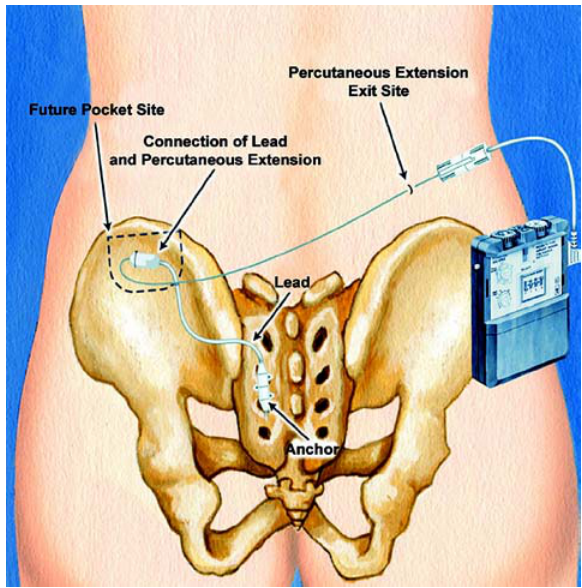
Figure 5 – Stage I sacral neuromodulation - External stimulator connected to chronic lead for test period.